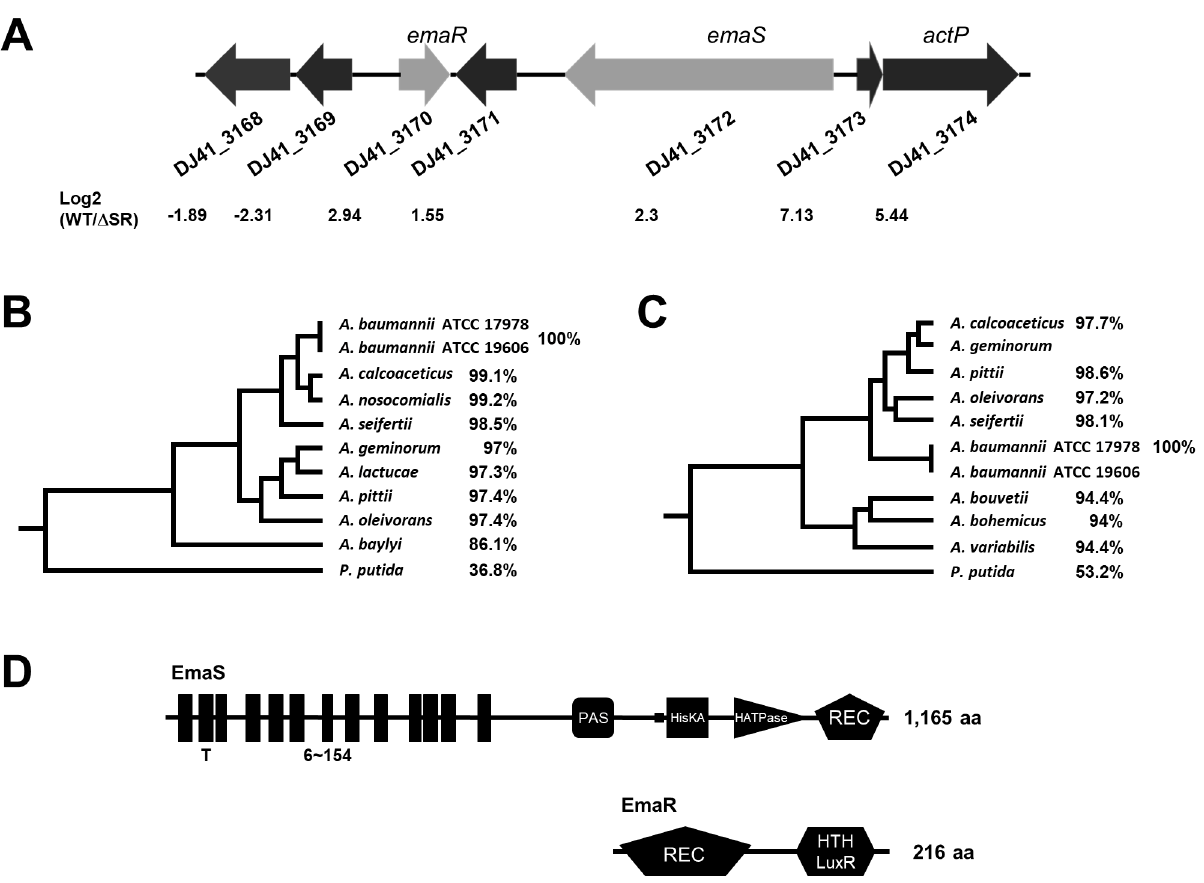
Figure 1. Gene arrangement and phylogenetic comparison of emaS and emaR . ( A ) Arrangement of emaS and emaR and surrounding genes (spanning DJ41_3168 ~ DJ41_3174 ). The numbers at bottom indicate the relative gene expression ratio of wild-type to emaSR ( Δ SR) mutant. ( B ) Phylogenetic trees constructed from amino acid sequence alignments of EmaS-like proteins from Acinetobactor species and MxtR of P. putida. Percentages indicate the amino acid identity of each protein to EmaS of A. baumannii . ( C ) Phylogenetic trees constructed from amino acid sequence alignments of EmaR-like proteins from Acinetobactor species and ErdR of P. putida. Percentages indicate the amino acid identity of each protein to EmaR of A. baumannii . ( D ) Domain structure of EmaS and EmaR. T, transmembrane domain; PSA, Per-Arnt-Sim domain; HisKA, histidine kinase domain for phosphorylation; HATPase, histidine ATPase domain; REC, response regulator domain; HTH LuxR, LuxR family helix-turn-helix domain.